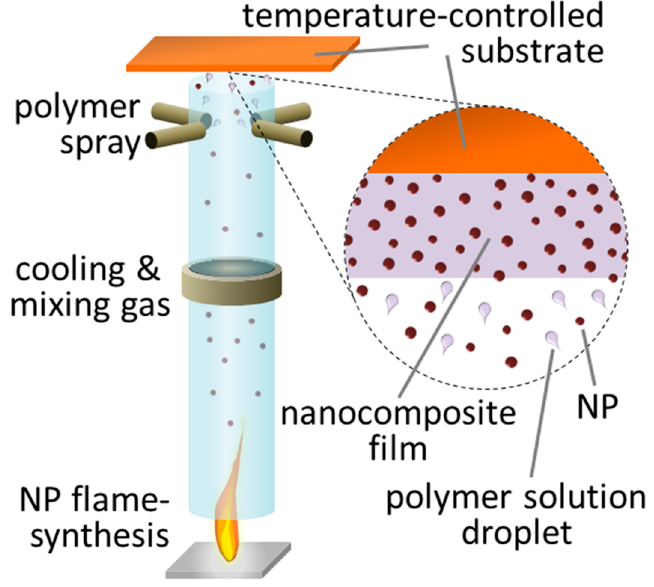
Figure 1. Set-up for of single-step nanocomposite fabrication combining flame synthesis of nanoparticles (filler) with simultaneous spraying of a polymer solution. Freshly-made